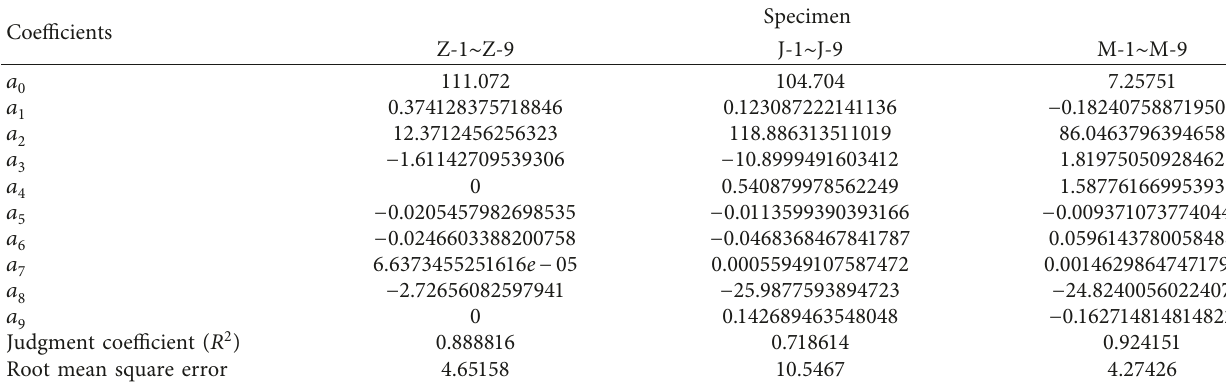
Table 9: Coefficients of quadratic polynomial model Equation